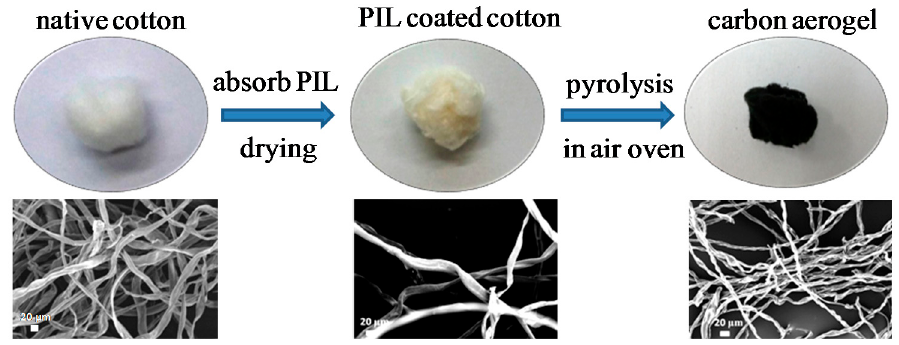
Figure 4. Preparation of carbon foam via carbonization in air and their corresponding SEM images (scale bar: 20 µM). (scale bar: 20 µ